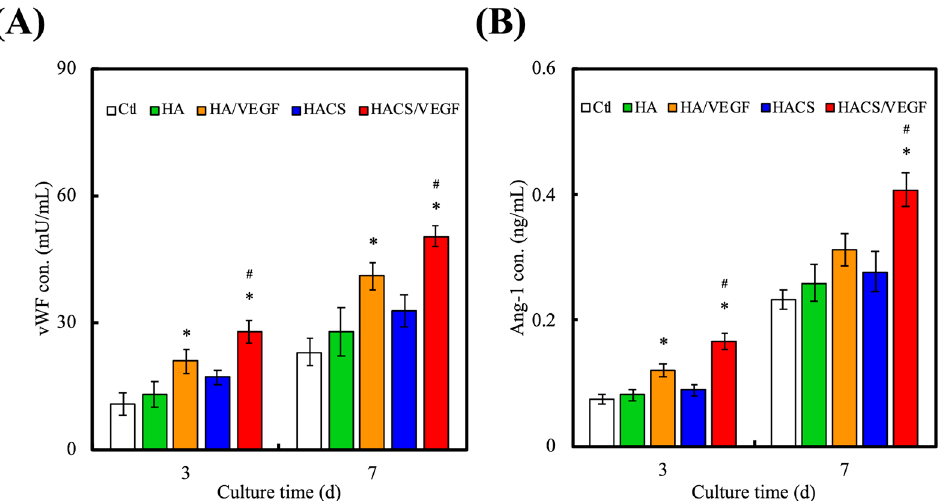
Figure 7. ( A ) The von Willebrand factor (vWF) and ( B ) Angiopoietin-1 (Ang-1) protein expression levels of HUVECs cultured on various scaffolds for 3 and 7 days. “*” indicates a significant difference ( p < 0.05) when compared to the scaffold without VEGF. “#” indicates a significant difference ( p < 0.05) when compared to HA/VEGF.